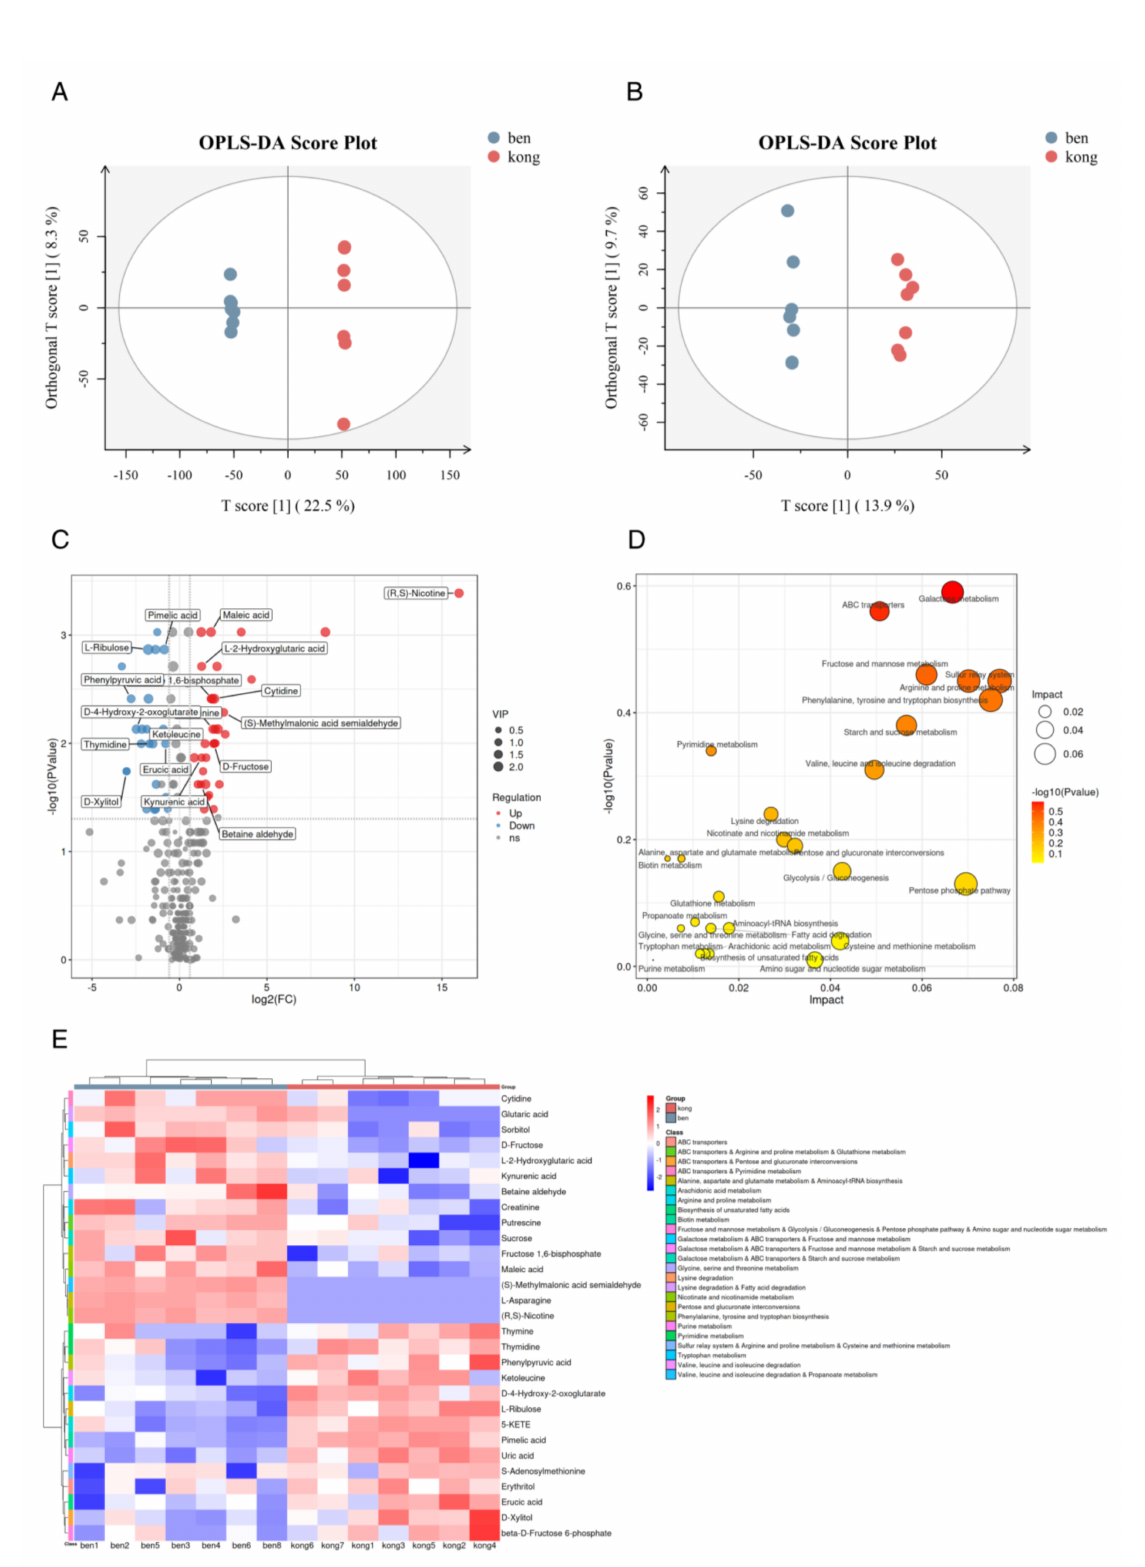
Figure 4. The metabolomic analysis of lumefantrine activity in T. gondii . ( A ) OPLS-DA of metabolite samples using electrospray ionization positive ion mode. OPLS-DA: orthogonal Partial Least Squares Discriminant Analysis. Seven replicates were included for both the drug-treated group and the non-treated group. The drug-treated group was denoted as “ben” and the non-treated group was denoted as “kong”. ( B ) OPLS-DA of metabolite samples using electrospray ionization negative ion mode. Seven replicates were included for both the drug-treated group and the non-treated